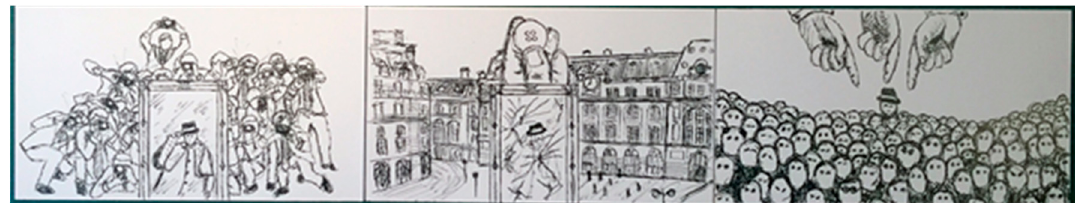
Figure 5. Exercises in Style, texticule: The Subjective Side developed in the Visual Design class 2016–2017 by student Guglielmo